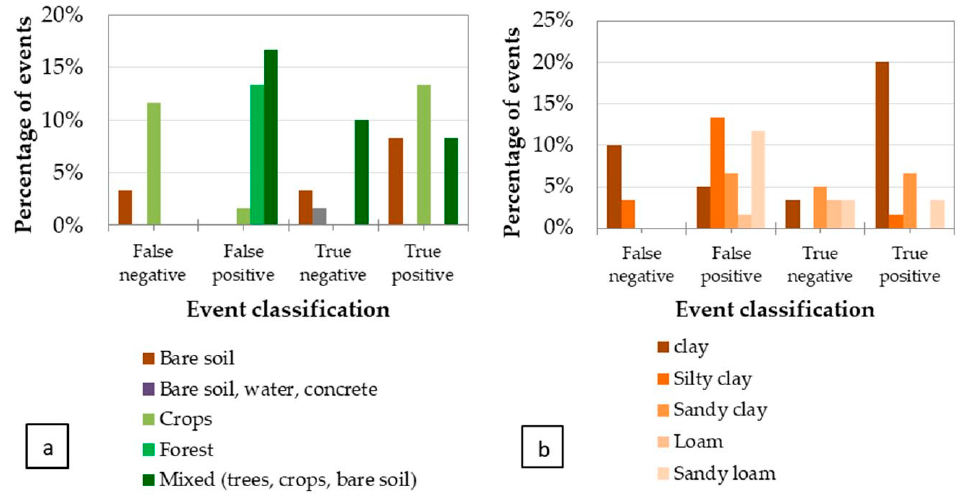
Figure 28. Relation between the event classification and ( a ) the type of vegetation or ( b ) the type of